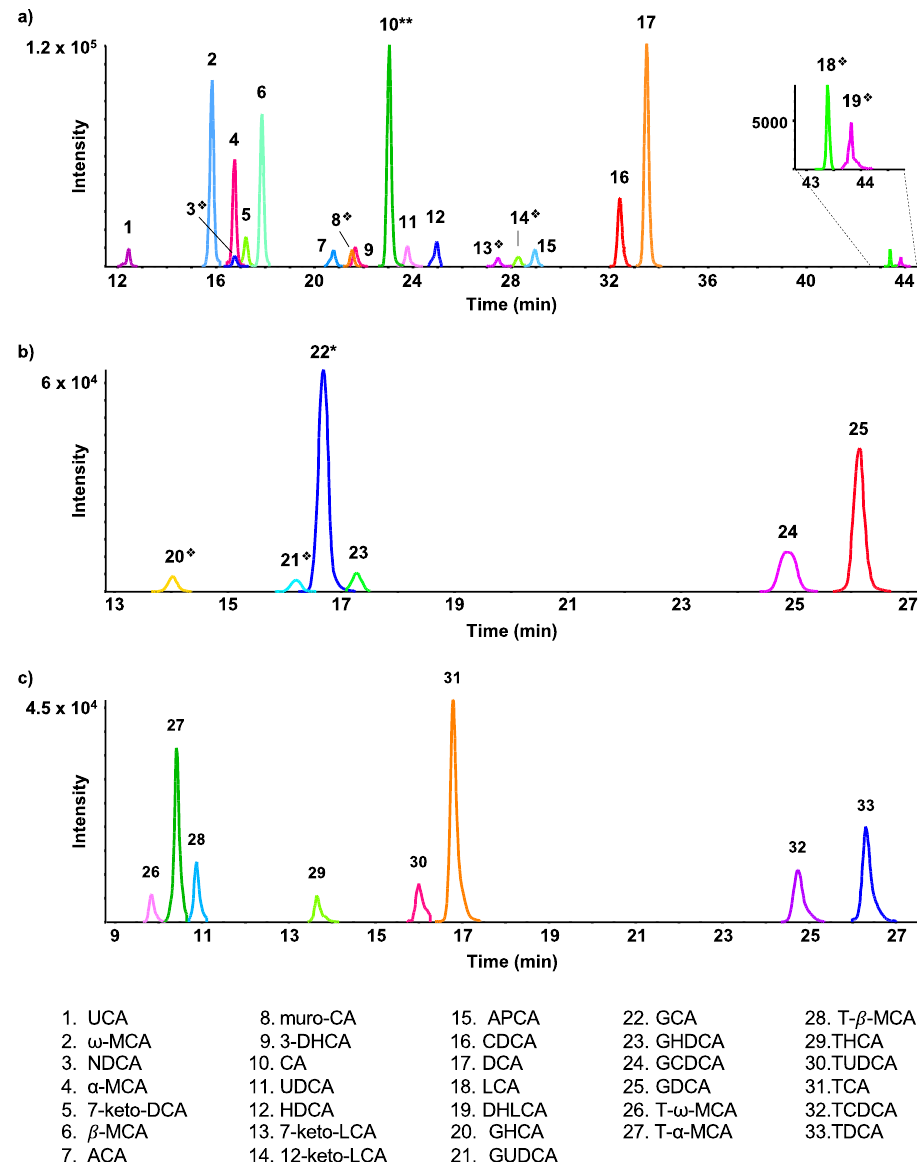
Figure 1. Extracted ion LC-MS chromatograms, in negative ion mode, of 33 known bile acids well detected in rat plasma 24 h following 600 mg/kg APAP dose, including unconjugated bile acids ( a ), glycine conjugated bile acids ( b ), and taurine-conjugated bile acids ( c ). The peaks were scaled and annotated as follows: * decreased 2×, ** decreased 6×, and ❖ increased 5×, for clarity. By comparing low- and high-dose groups, statistically significant changes were found with area ratios normalized using deuterated internal standards (Table S1) for 13 BAs from the standard mix (Figure 2, Table S2). Three glycine-conjugated BAs (GCA, GDCA, and GHDCA) increased significantly, whereas no taurine-conjugated BAs were shown to vary significantly. In general, taurine-conjugated bile acids predominate over glycine-conjugated ones in rats [29]. However, when APAP is taken in excess, GSH re- serves are depleted [14], and since glutathione and taurine are biosynthesized using the same precursor, cysteine, this could hinder the synthesis of taurine and thus reduce its levels in the body [9]. Our results, consistent with those of Yamazaki et al. [9], show that